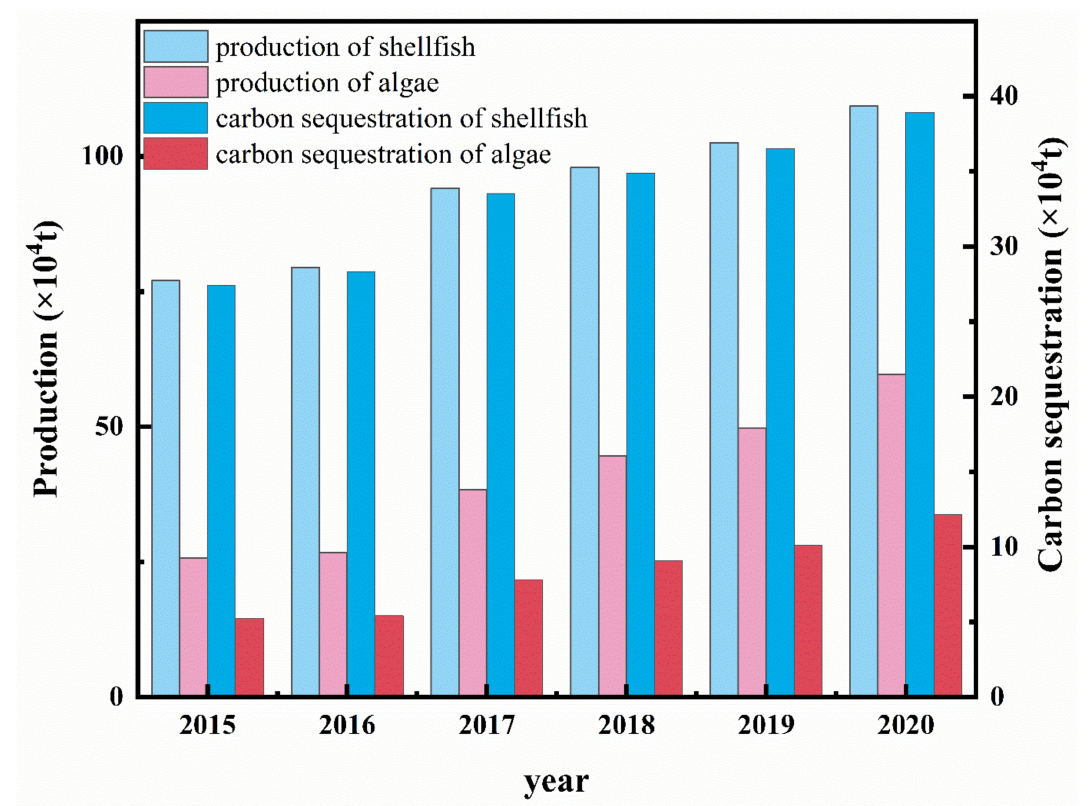
Figure 6. The production (wet weight) of shellfish and algae between 2015 and 2020 in Zhejiang Province. The production of algae (wet weight) was calculated by the dry weight of algae and the dry weight ratio of algae (20%). The carbon sequestration was calculated based on the produc- tion (wet weight) and the carbon sink coefficient of shellfish and algae, respectively. Data source: Zhejiang Statistical Yearbook 2021